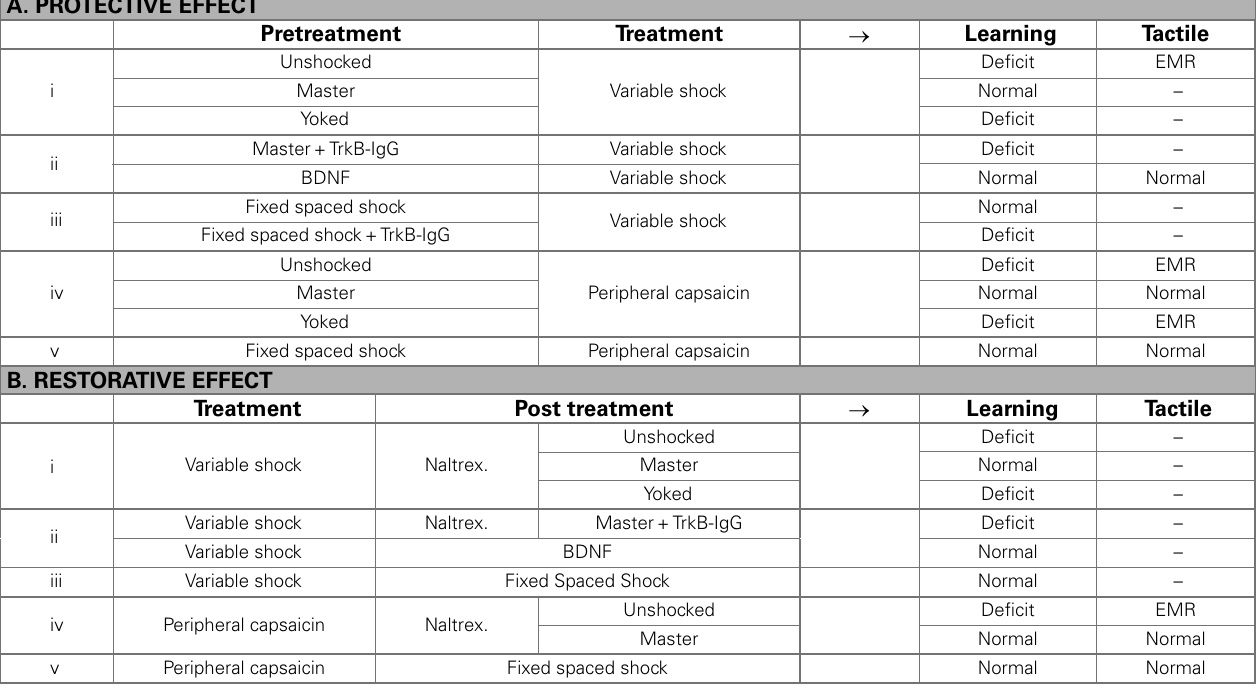
Table 1 | Impact of instrumental training (i, ii, and iv), or an extended exposure to fixed spaced shock (iii and v), on the learning deficit and the enhanced mechanical reactivity (EMR) induced by variable shock (i and iii) or capsaicin (iv and v)